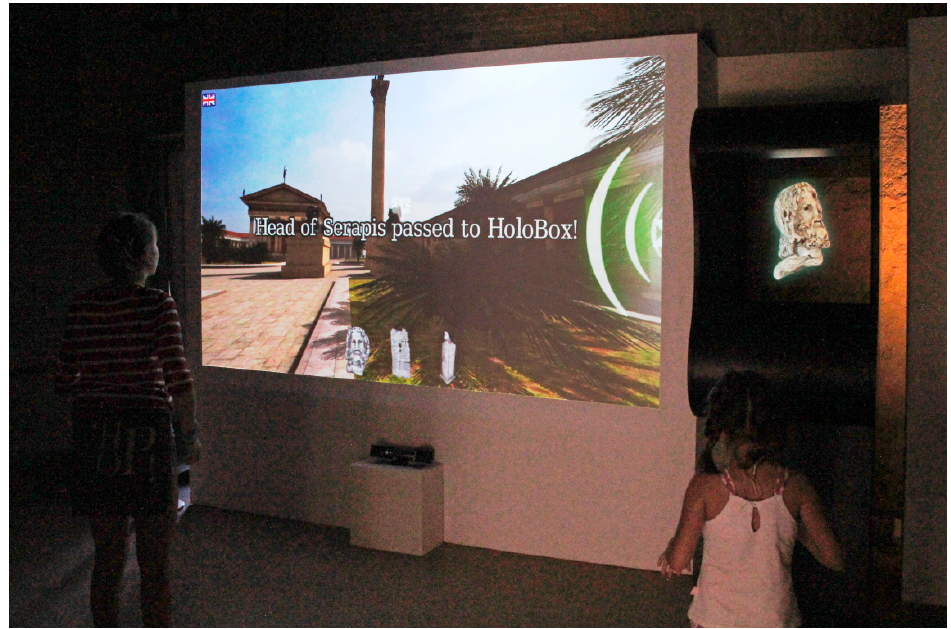
Figure 9. Keys2Rome, CNR ITABC, 2014, Imperial Fora Museum.